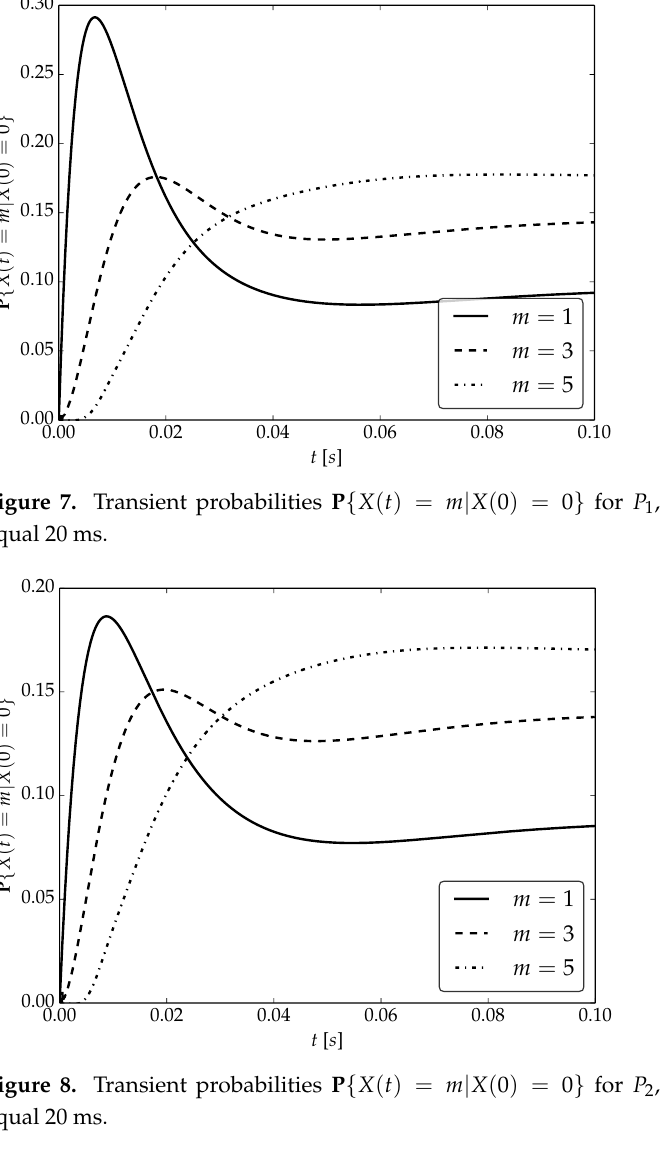
Figure 8. Transient probabilities P equal 20